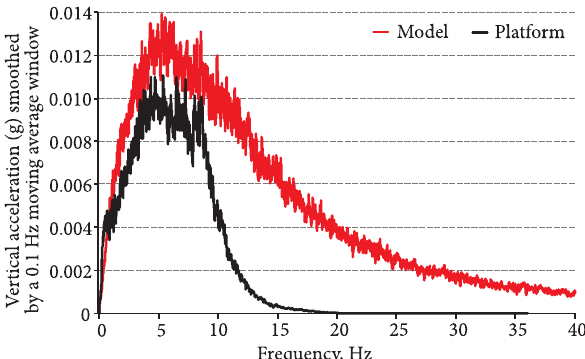
Fig. 3. Comparison of the spectrum of accelerations for IRI 4 m/km Table 2. Results of the questionnaire on irregularities Question